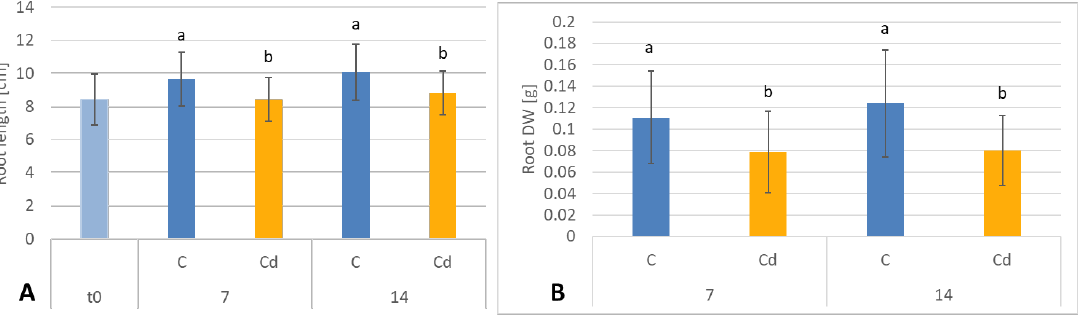
Figure 14. The length ( A ) and dry weight ( B ) DW of C. officinalis plant shoots. t0 (light blue bar)- shoot length of three-week-old seedlings. Bars which do not share a common letter are significantly different ( p < 0.05).